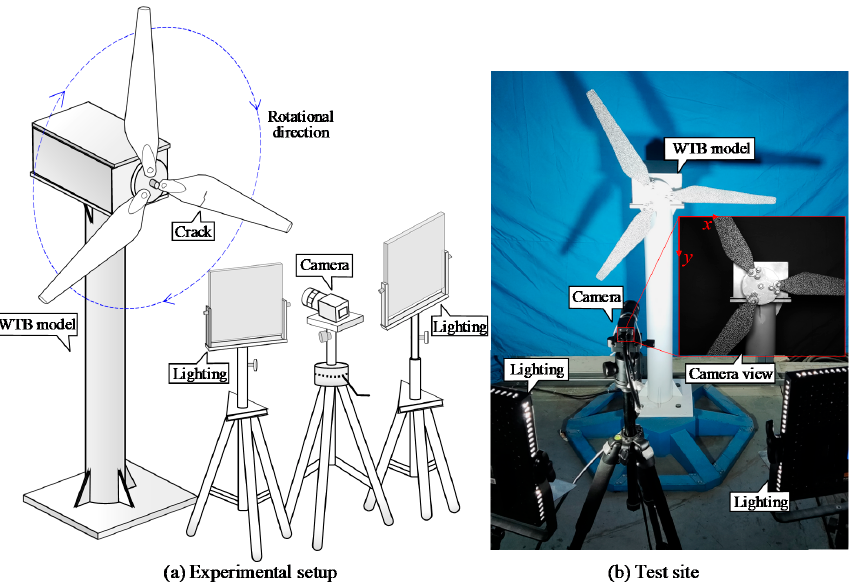
Figure 10. Deformation monitoring of rotating blade setup: ( a ) Experimental setup; ( b ) Test site. Accurately identifying the displacement of the rotating blade is the precondition for the determination of the dynamic deformation field. The image taken by the shutdown state of the WTB is used as a reference image. The pixel point at the preset crack and its two adjacent pixels points along the length of the blade with intervals of 200 pixels (35.7 mm) are used as the three measured points. In order to check the effect of cracks on the blade trajectory, three measured points on a healthy blade with the same length from the center of the hub are selected. Table 2 shows the location of measured points. Table 2. Location of measured points of experiment 2. Case